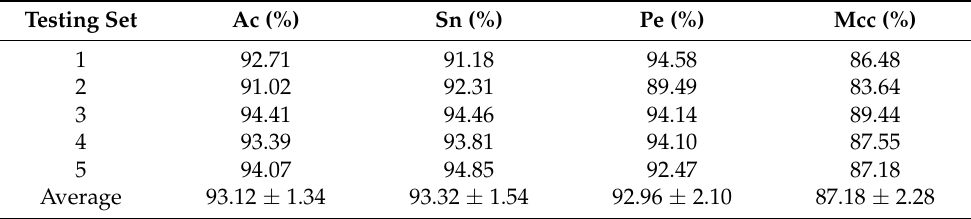
Table 2. 5-fold cross validation results performed by proposed model on an ion channel dataset. Testing Set